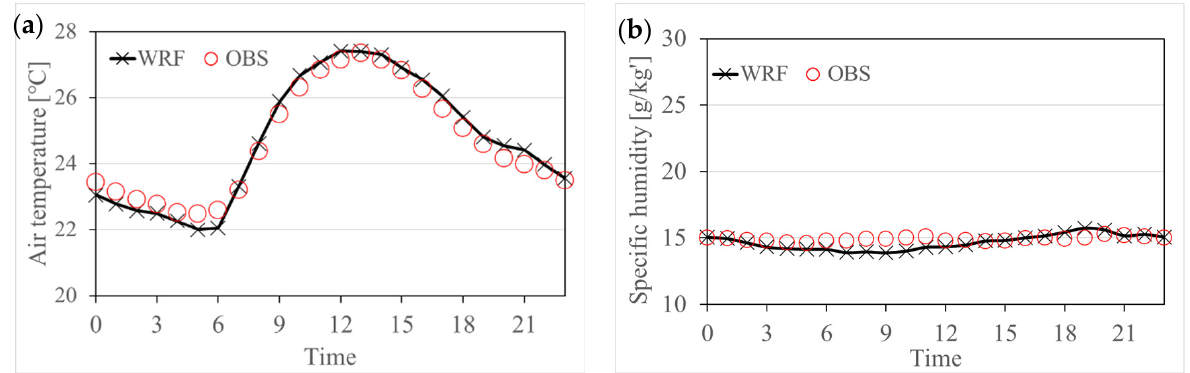
Figure 5. Validations for air temperature and speci fi c humidity. ( a ) Diurnal variations of air temperature averaged for sunny days in August 2002; ( b ) diurnal variations of speci fi c humidity averaged for sunny days in August 2002.